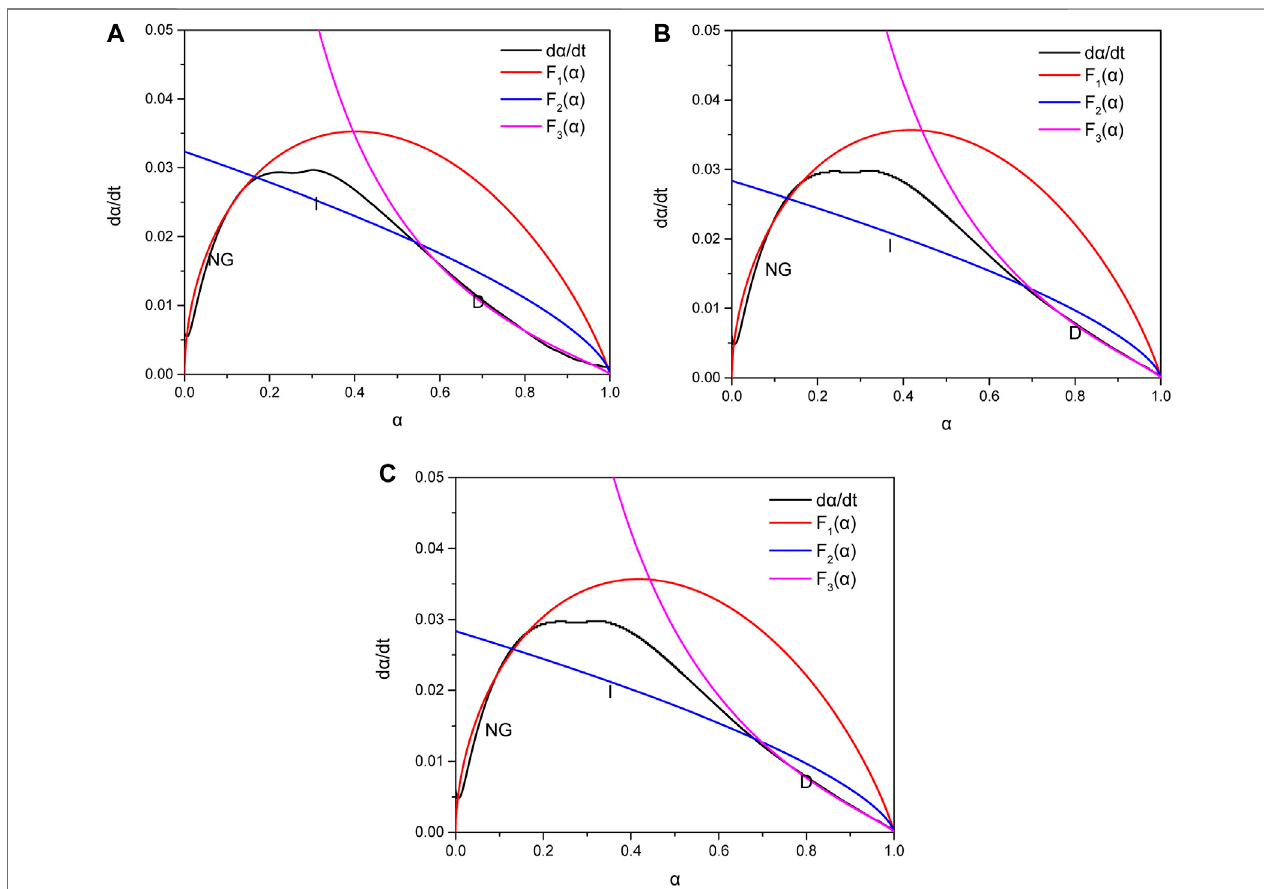
FIGURE 9 | Heat release rate curve showing (A) control, (B) low-heat cement with 0.2% MSR, and (C) low-heat cement with 0.3% MSR.